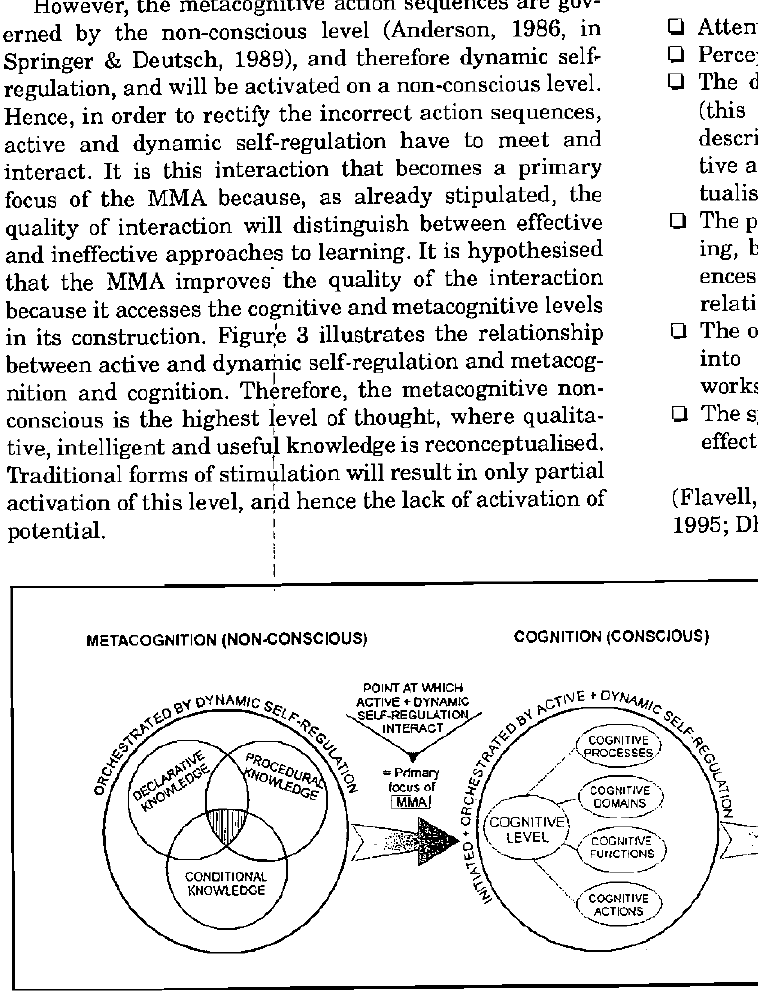
FIGURE 3: The Interaction between Active and Dynamic Self-Regulation Die Suid-Afrikaanse Tydskrif vir Kommunikasieafwykings, Vol. 44,